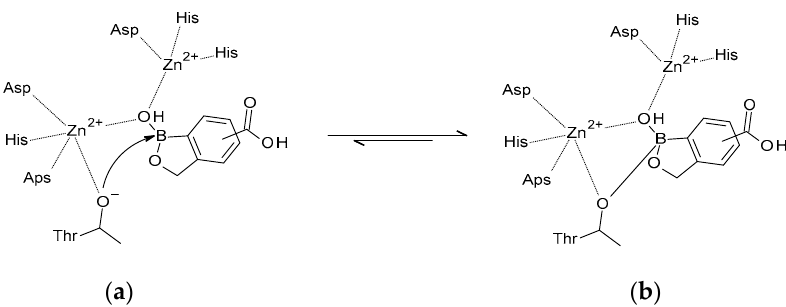
Figure 3. Formation of an adduct of benzoxaborole in the ATX active site according to literature [12]. ( a ) Nucleophilic attack on benzoxaboroles by catalytic threonine oxygen side chain; ( b ) reversible covalent tetrahedral adduct.